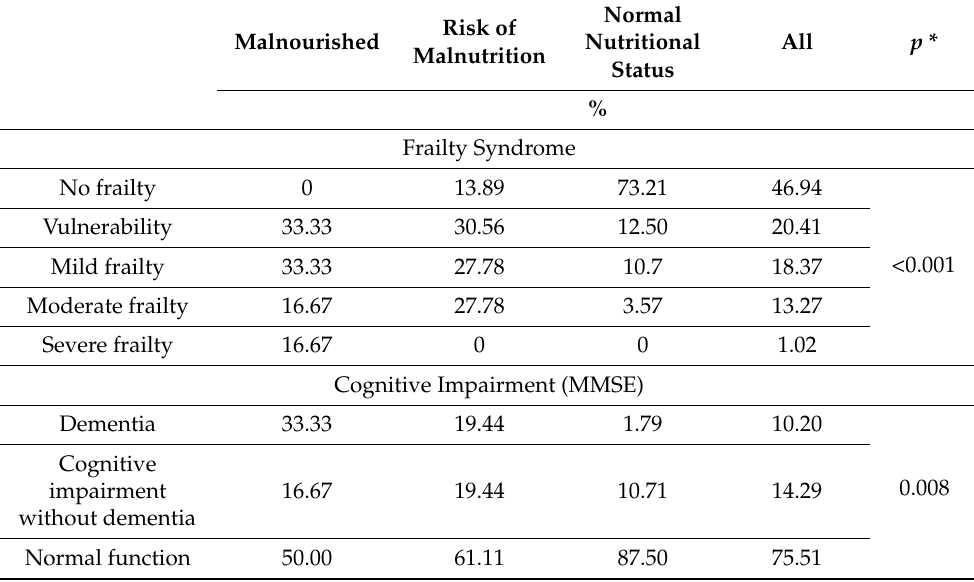
Table 4. Prevalence of frailty and cognitive impairment by nutritional